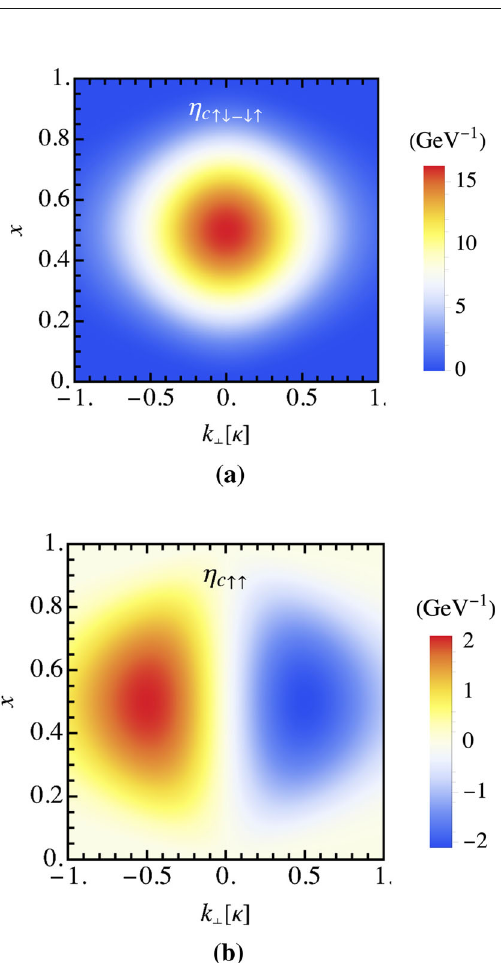
Fig. 6 Plot of the η c wavefunction according to Eq. (50) as a function of x and (cid:3) k ⊥ at θ k = 0 ,π , with the basis parameter κ = 1 . 34 GeV, a ψ ↑↓−↓↑ /η ( (cid:3) k ⊥ , x ) , b ψ ↑↑ /η ( (cid:3) k ⊥ , x ) = ψ ∗ ( (cid:3) k ⊥ , x ↓↓ /η c c c